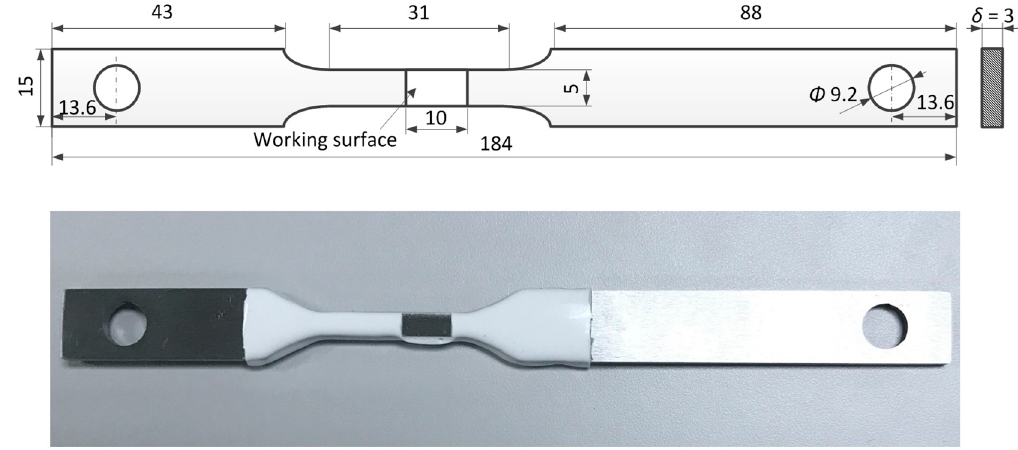
Figure 2. The geometry and the size of the X80 steel specimen (unit: mm).